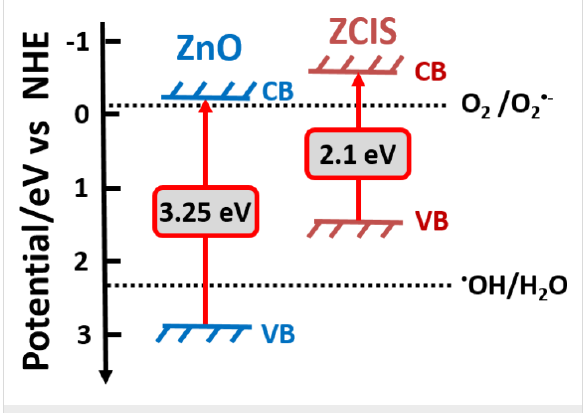
Figure 4: Band structure of ZnO and ZCIS QDs and redox potentials of O 2 /O 2• − and • OH/H 2 O couples.